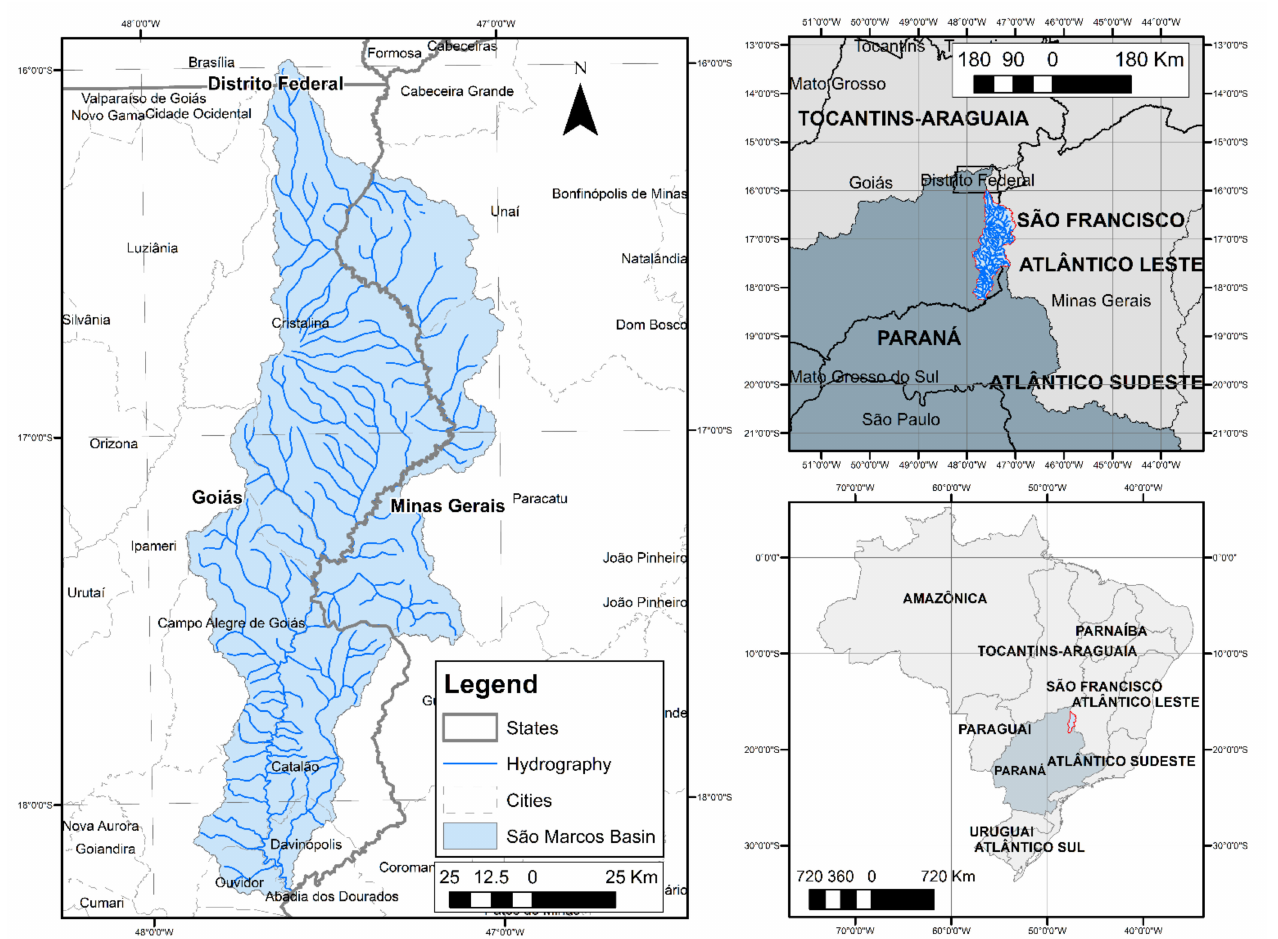
Figure 1. S ã o Marcos River